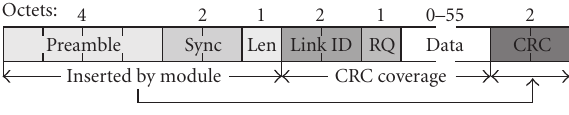
Figure 2: The frame